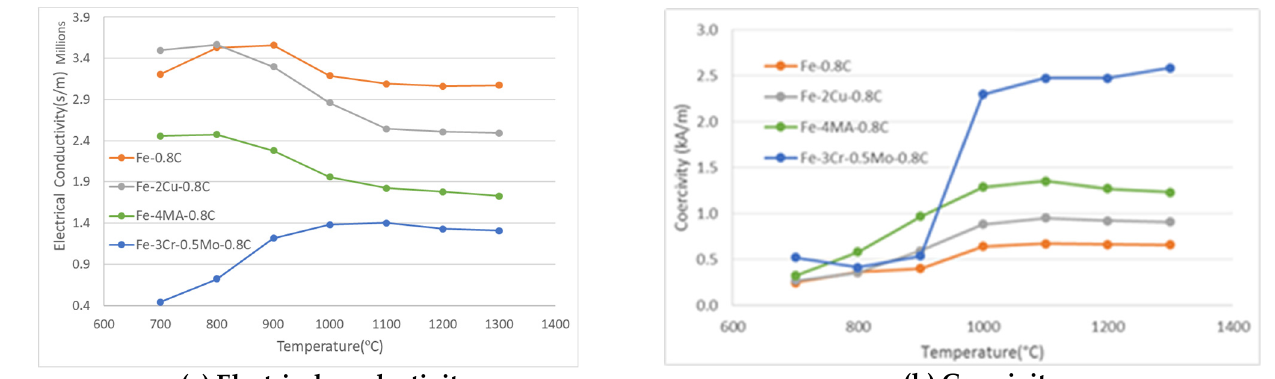
Figure 9. Physical properties of steels compacted at 600 MPa and sintered for 60 min at different temperatures in Ar.